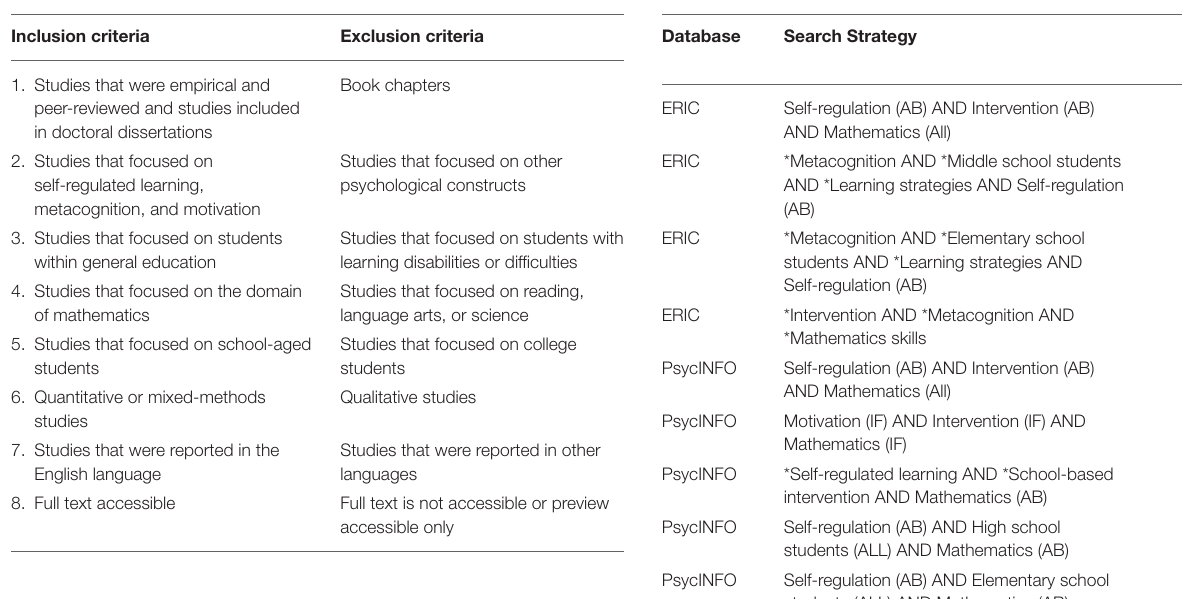
TABLE 1 | Inclusion and exclusion